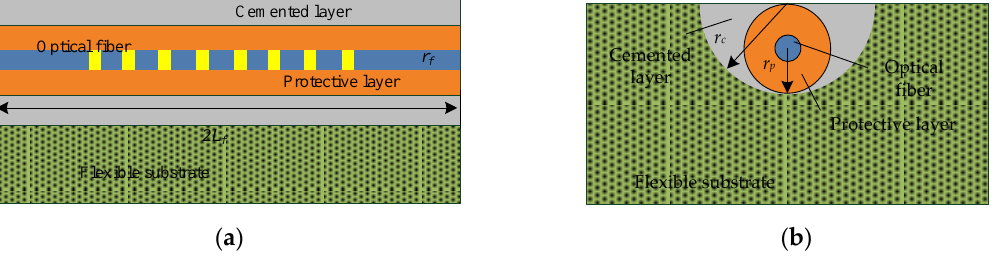
Figure 8. Schematic diagram of grooved-bonded strain-transfer model: ( a ) front view; ( b ) side view. The strain-transfer model between the layers is shown in Figure 9. It is stipulated that E , G , τ , σ , ε , and u represent the elastic modulus, shear modulus, shear stress, axial